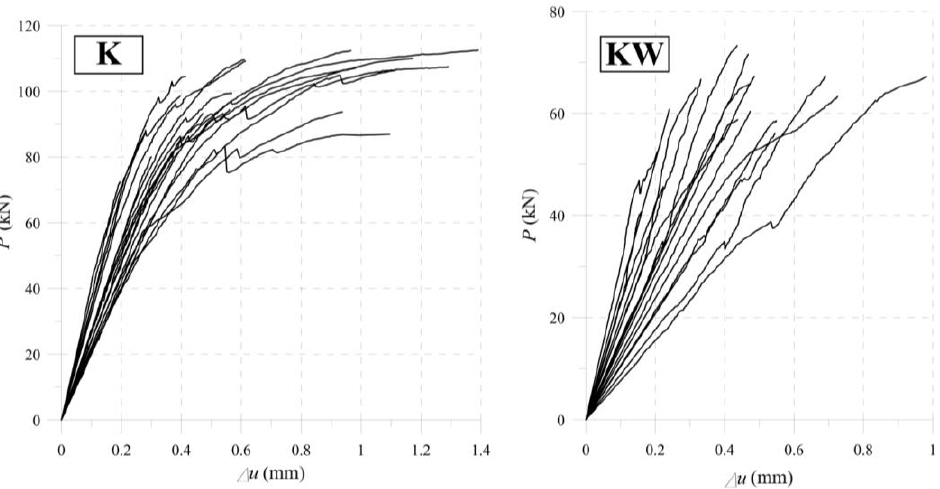
Figure 12. Laboratory tests results for the “K” and “KW” samples.